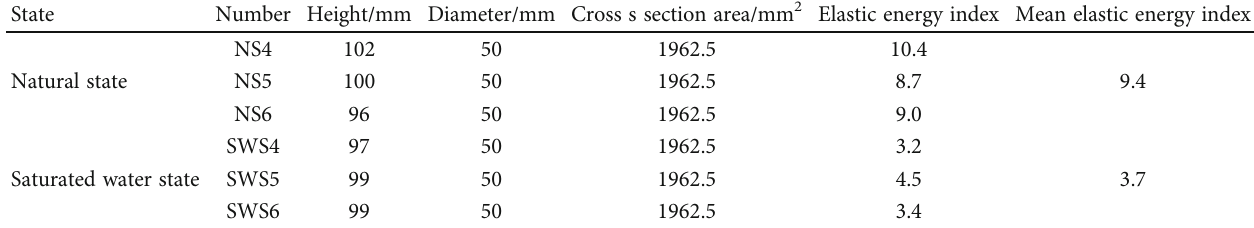
) under di ff erent states. ET